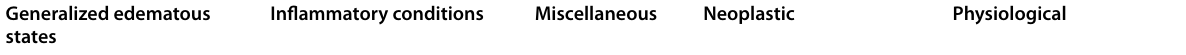
Table 2 Causes of gallbladder wall thickening (Modified from [39]) Generalized edematous states